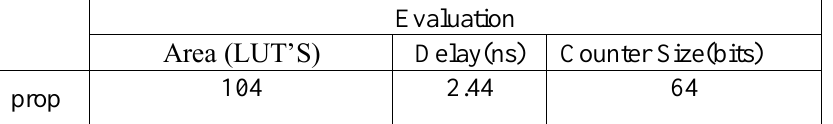
Table 1. Performance analysis and evaluation of the proposed design of the counter.